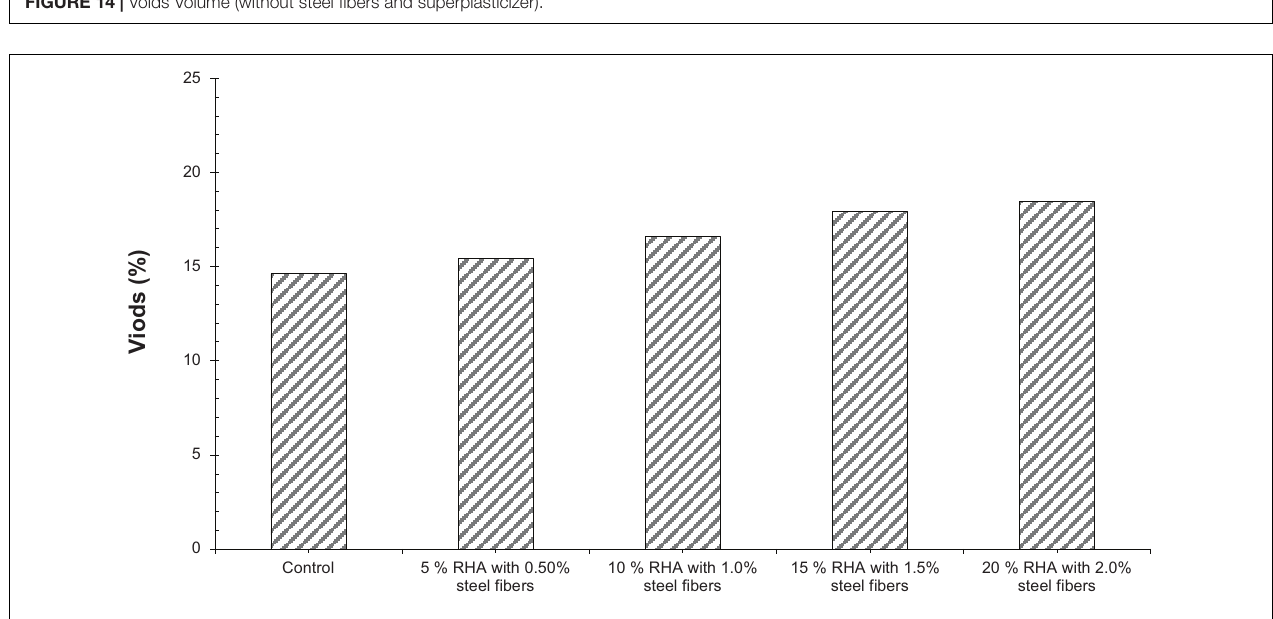
FIGURE 15 | Voids Volume (with steel fibers and